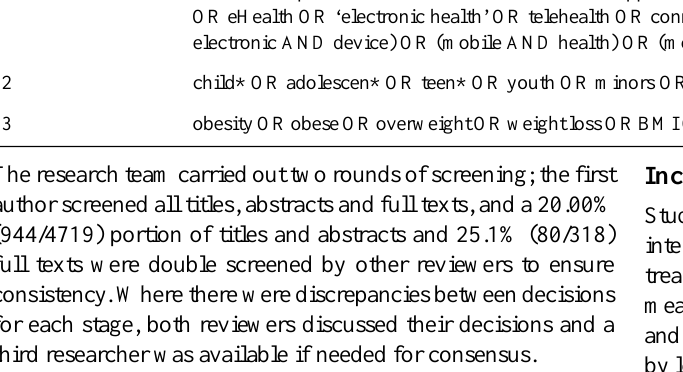
Search stringComponent